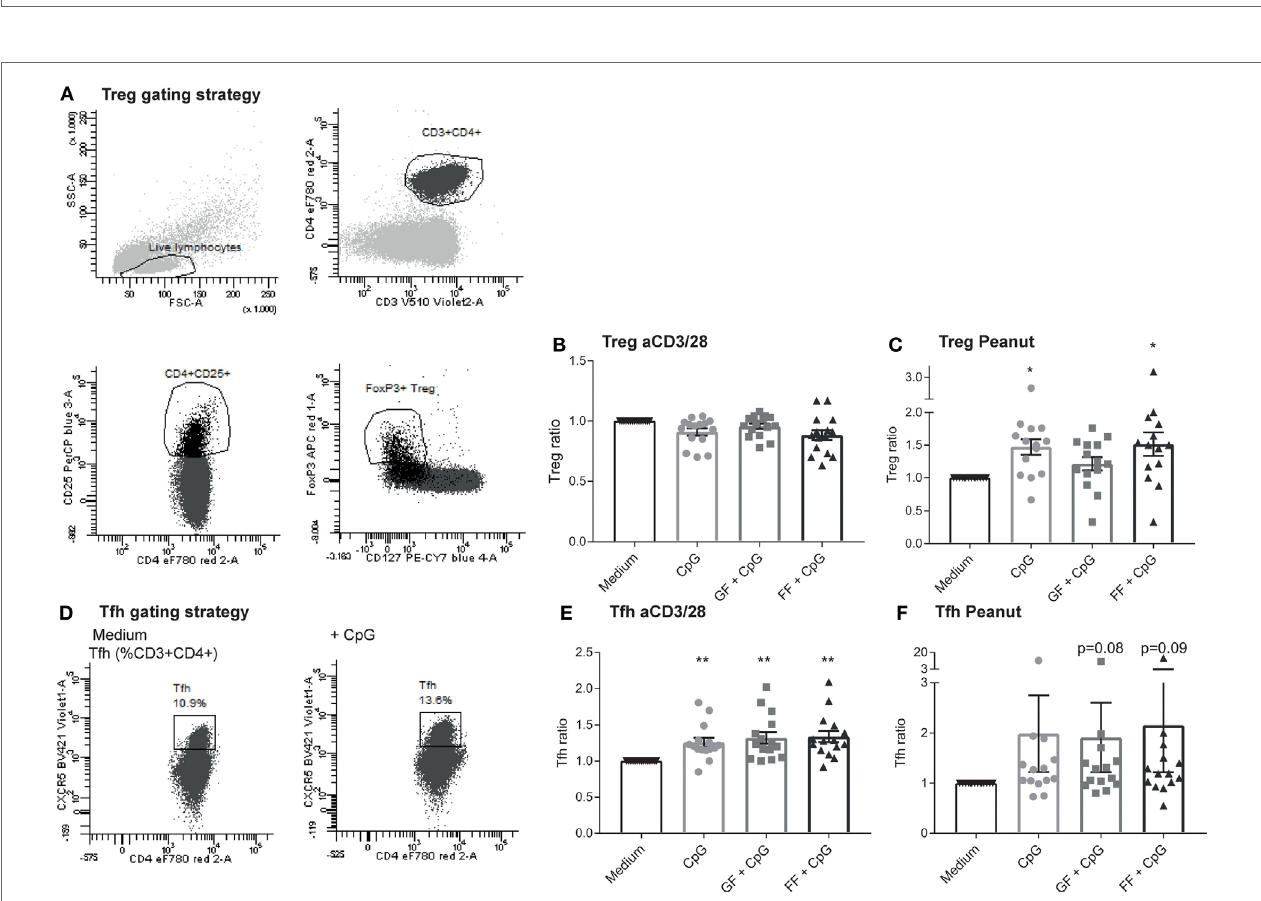
FigUre 6 | Increased percentage of regulatory T cells (Treg) and Tfh subsets in the peanut-specific co-culture model upon exposure to intestinal epithelial cells (IECs) to CpG oligodeoxynucleotides (ODN). Tregs were gated as indicated (a) . Treg polarization in the aspecific co-culture model was not altered upon exposure of IECs to CpG ODN, and no contributions of the oligosaccharides were observed (B) , whereas in the peanut-specific model, the Treg population increased upon CpG exposure (c) . Tfh were gated as indicated (D) . The percentage of Tfh cells increased upon CpG exposure of IECs, but was not further enhanced by the oligosaccharides (e) . In the peanut-specific model, Tfh also increased upon CpG exposure of IECs (F) . Data represent n = 15 peanut-allergic patients, mean ± SEM, * P < 0.05, ** P < 0.01, *** P < 0.001 by one-way ANOVA. Short-chain galacto-oligosaccharides and long-chain fructo-oligosaccharides (scGOS/ lcFOS) (GF), scFOS/lcFOS (FF).